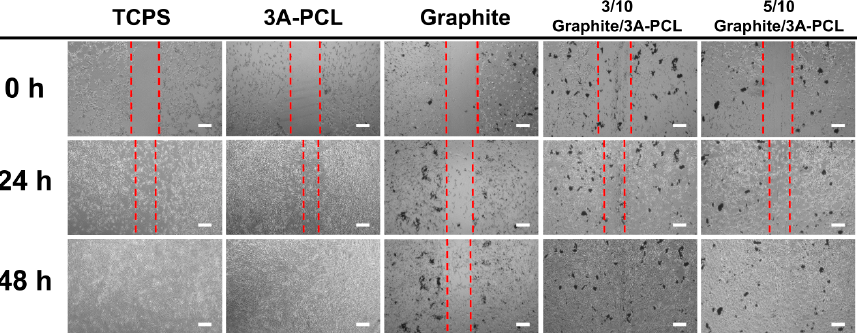
Figure 4. Results of in vitro scratch wound healing assay. Linear scratches were created in the monolayer of NIH/3T3 cells cultured on TCPS, 3A-PCL, graphite, 3/10 and 5/10 graphite/3A-PCL substrates. Images of the scratched areas were monitored through a phase-contrast microscope at 0, 24 and 48 h after wounding. The dashed red lines denote wound edges. All white scale bars represent 100 μ m.